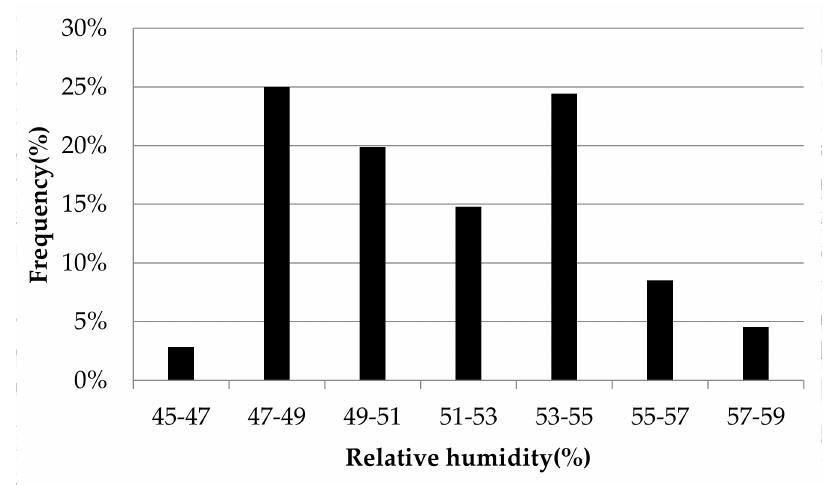
Figure 8. Frequency of the indoor air relative humidity in